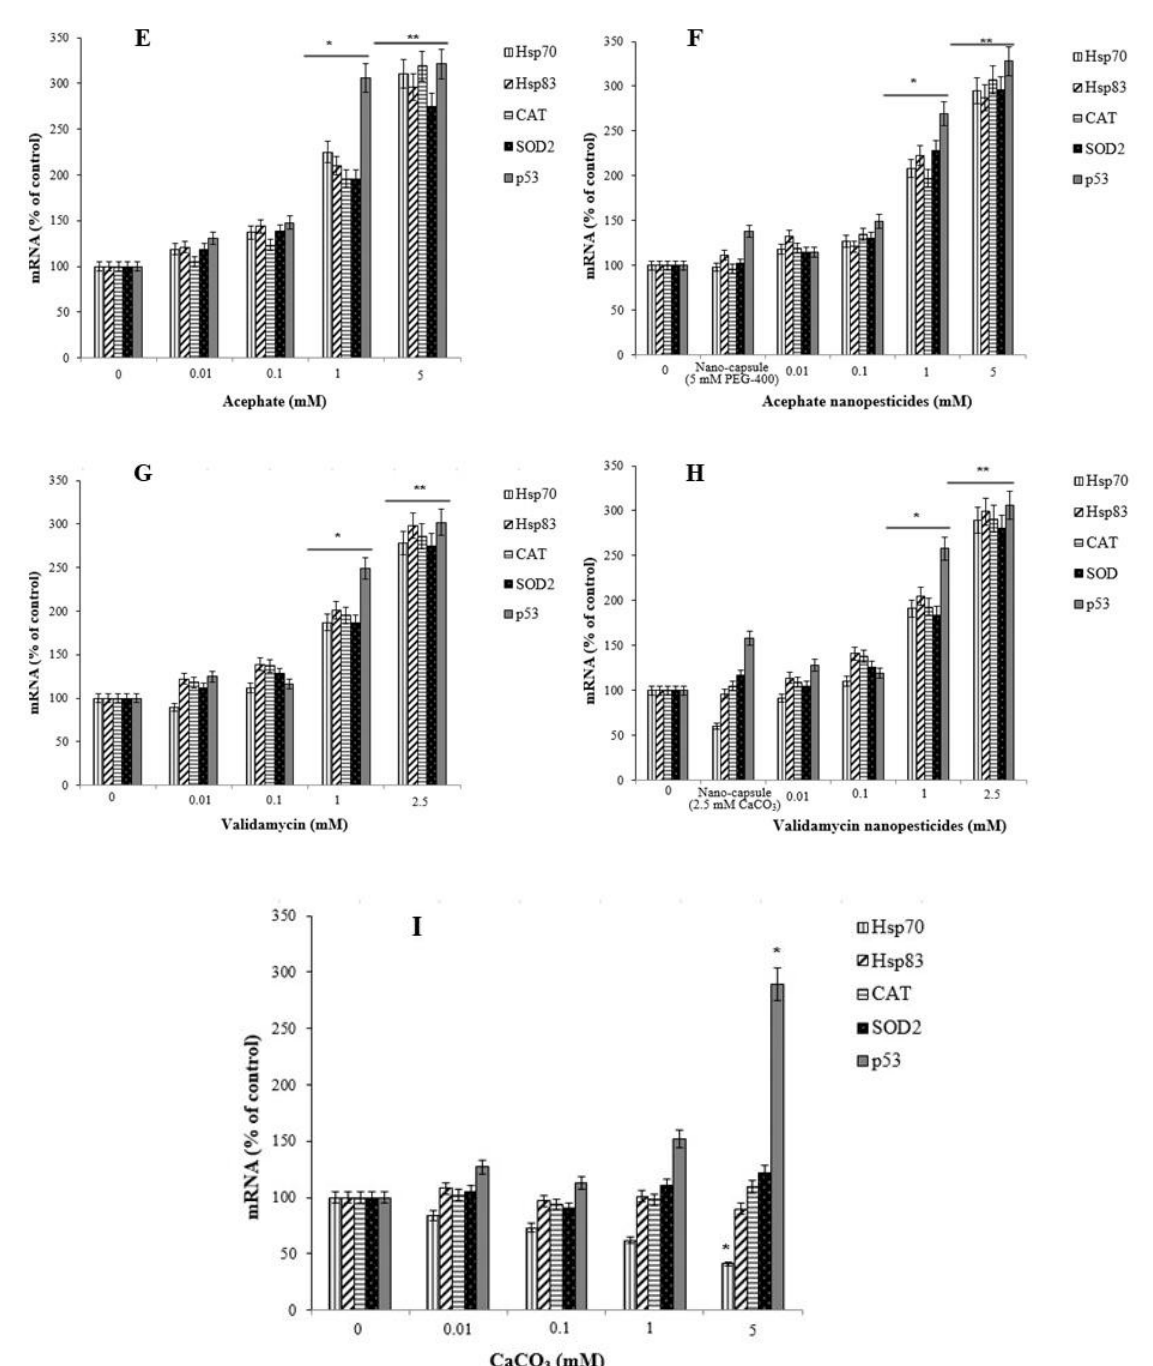
Figure 12. The expression of Hsp70 , Hsp83 , CAT , SOD2 , and p53 in 96 h larvae induced after exposure to different doses of permethrin ( A ), permethrin nanopesticides ( B ), CuSO 4 · 5H 2 O ( C ), Cu(OH) 2 nanopesticides ( D ), acephate ( E ), acephate nanopesticides ( F ), validamycin ( G ), validamycin nanopesticides ( H ), and CaCO 3 ( I ). The expressions were normalized using β -actin, and are presented compared to control values. Data represent the mean ± standard error of the mean of six independent experiments; * p < 0.05, ** p < 0.01 (Student’s t -test). Exposure to pesticides and nanopesticides, as well as different xenobiotic com- pounds, can activate different metabolic or physiological pathways according to their mechanism of action. Therefore, changes in the expression of many different genes